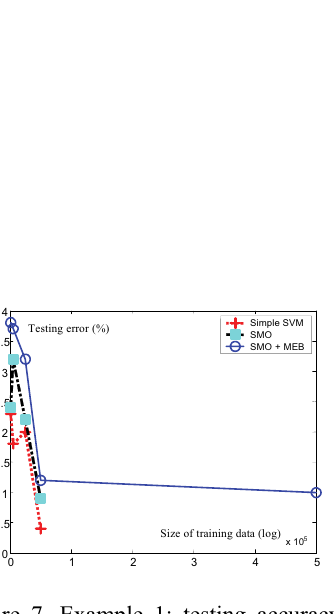
Figure 7. Example 1: testing accuracy vs training data size